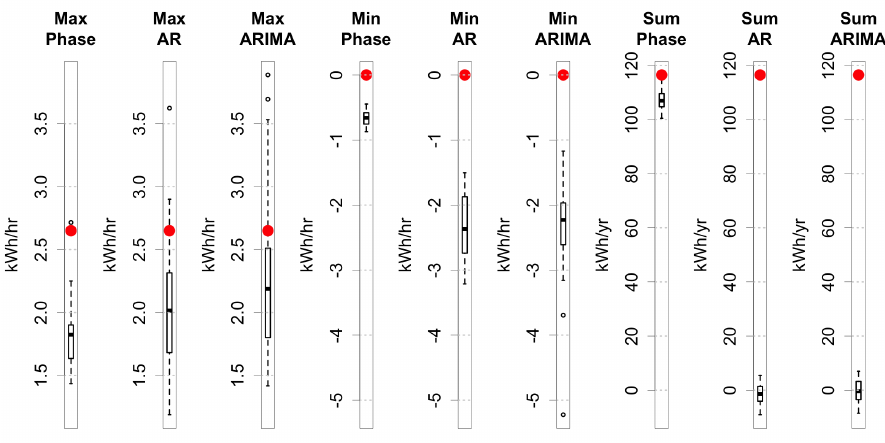
Figure 17. Boxplots of maximum, minimum and sum compared the performance of reconstruction methods in simulating the 5 a.m. hourly energy usage by the electric DHW heater in RBSA home 13088, from Q2 2012–Q1 2013 inclusive. Statistics of empirical observations are denoted by red dots. Note: (a) the significant variances in the maximum statistic would adversely affect load shaping calculations, (b) the minimum statistic included unrealistic negative values, and (c) Mean values of zero in the AR and ARIMA sum statistics were